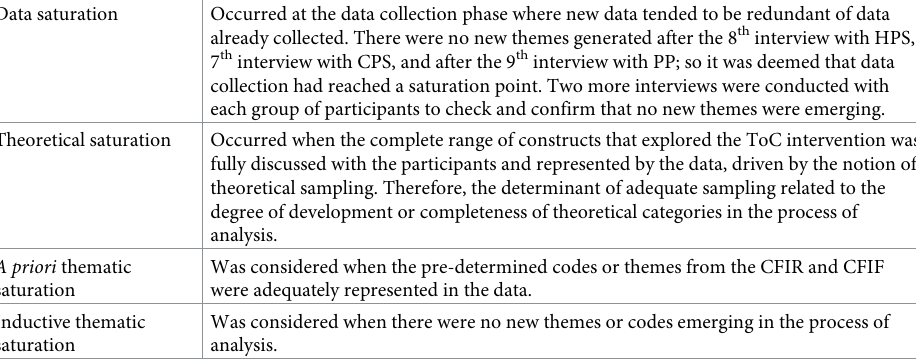
Table 3. Models of saturation considered in this